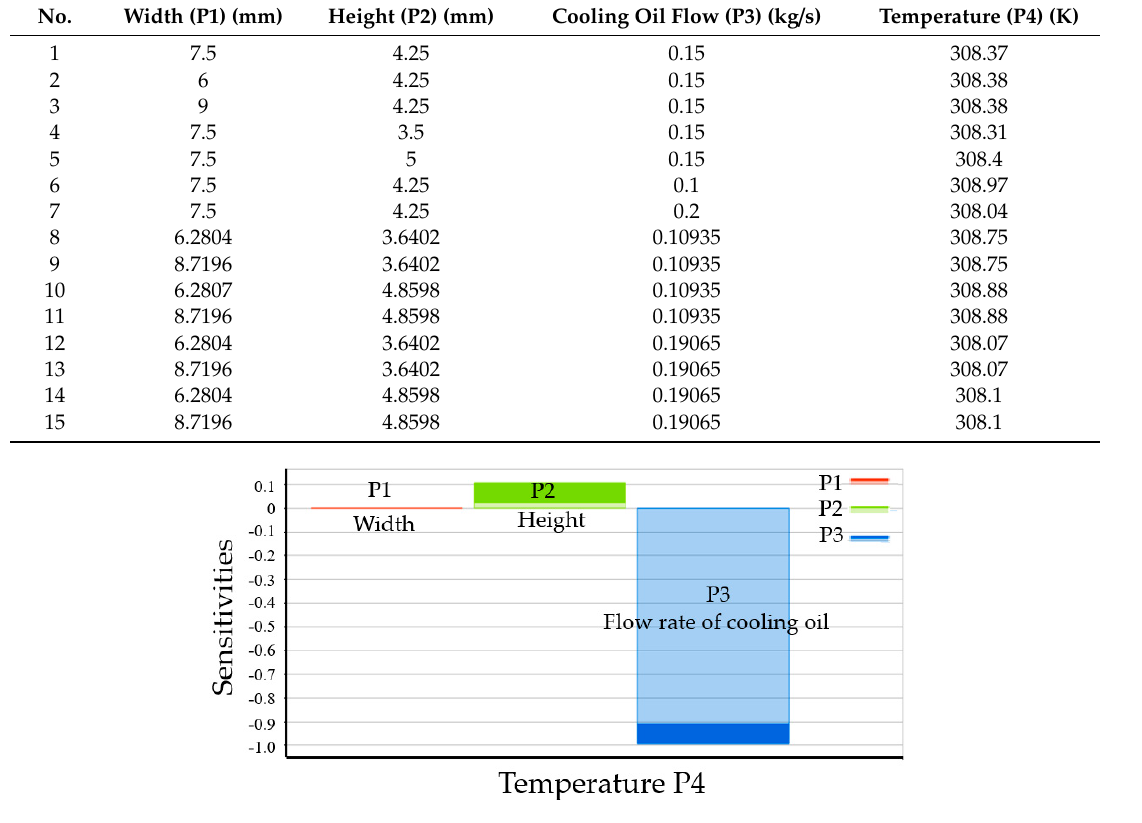
Figure 10. Sensitivity analysis.